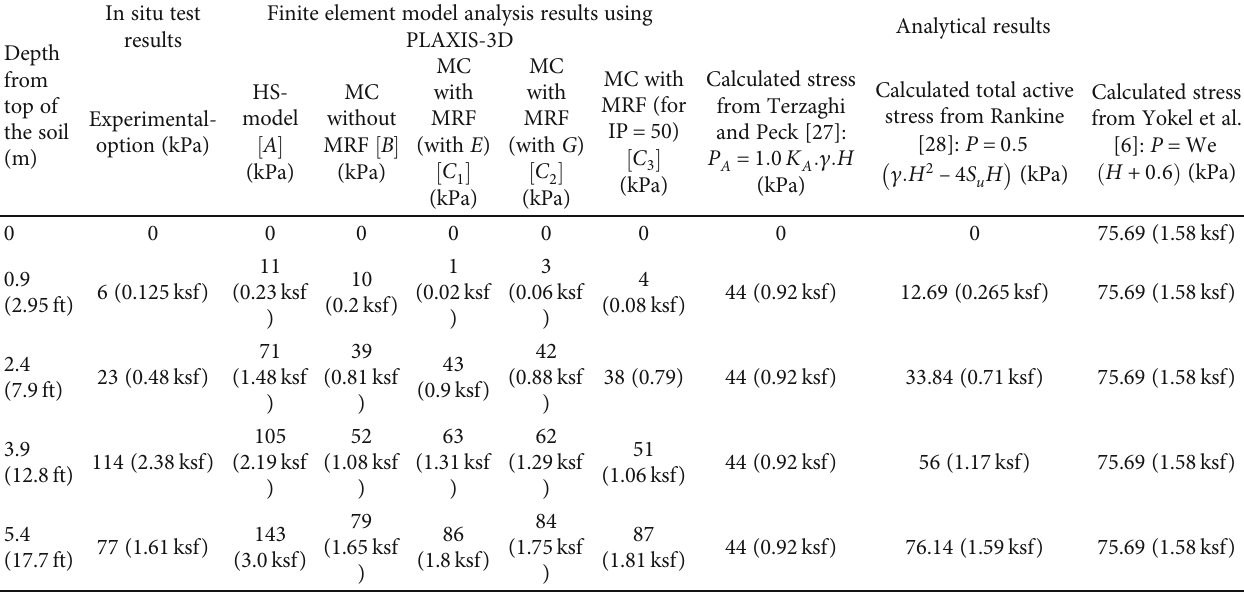
Table 11: Comparison of soil pressures on fl exible temporary shield in soft and sensitive clay excavated